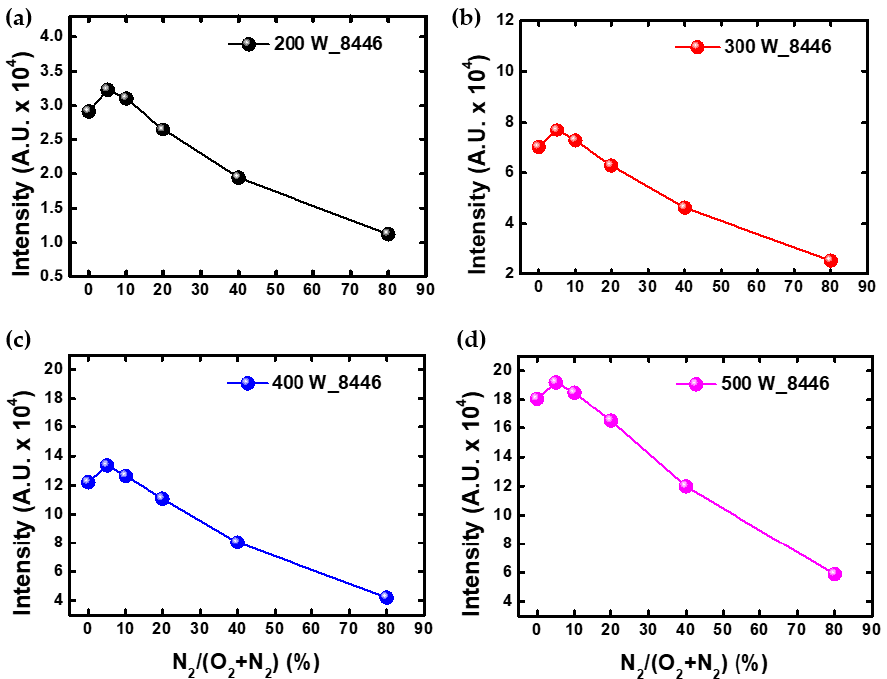
Figure 4. This is the oxygen radical intensity of 8446 Å measured using OES at ( a ) 200 W, ( b ) 300 W, ( c ) 400 W, and ( d ) 500 W.